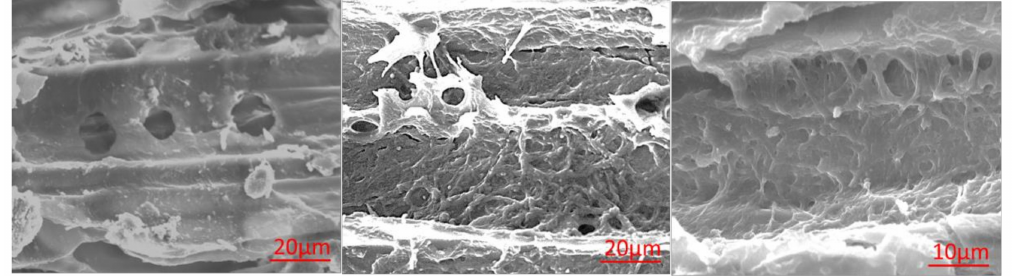
Figure 7. SEM micrographs of the un-impregnated group ( left ) and the PEG4000 impregnated group ( center and right